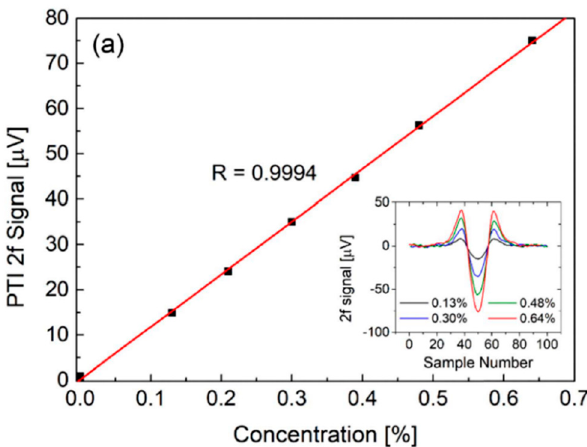
Figure 13. Linear response of the PTI sensor shown in [66] to the CO concentration. Inset shows the PTI spectra measured at different CO concentrations. Reprinted with permission from [66], © The Optical Society.